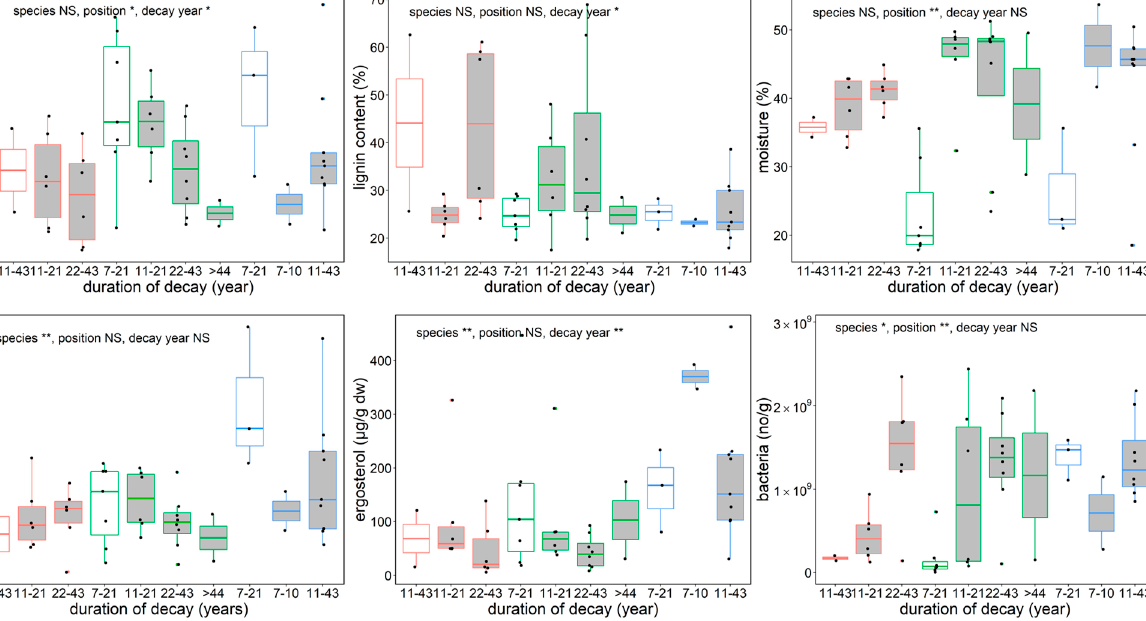
Figure 2. Physico–chemical and biological features and in situ respiration rate of beech, spruce, and fir dead wood snags and logs in an old-growth forest in the Zofin Forest by species and duration of decay. The significance of the effect of tree species, dead wood position, and decay length are indi- cated with asterisks (ANOVA, * p < 0.05, ** p < 0.01). 3.2. Microbial Community Composition and Ecological Traits In total, 532,265 fungal sequences were obtained and clustered into 9,853 OTUs. After removal of non-fungal sequences and singletons, there were 3,745 OTUs. Taxonomic eval- uation revealed that most of the OTUs belong to the phylum Ascomycota and Basidiomy- cota (Figure 3). There were different ratios in the dead wood categories. Fir snags and logs and young spruce logs had more Basidiomycota, whereas spruce snags and old logs and beech snags and logs had much more Ascomycota than Basidiomycota. The most abun- dant genera were Protounguicularia , Spadicoides , Cystostereum , Fomitopsis , Hyphodonitia ,